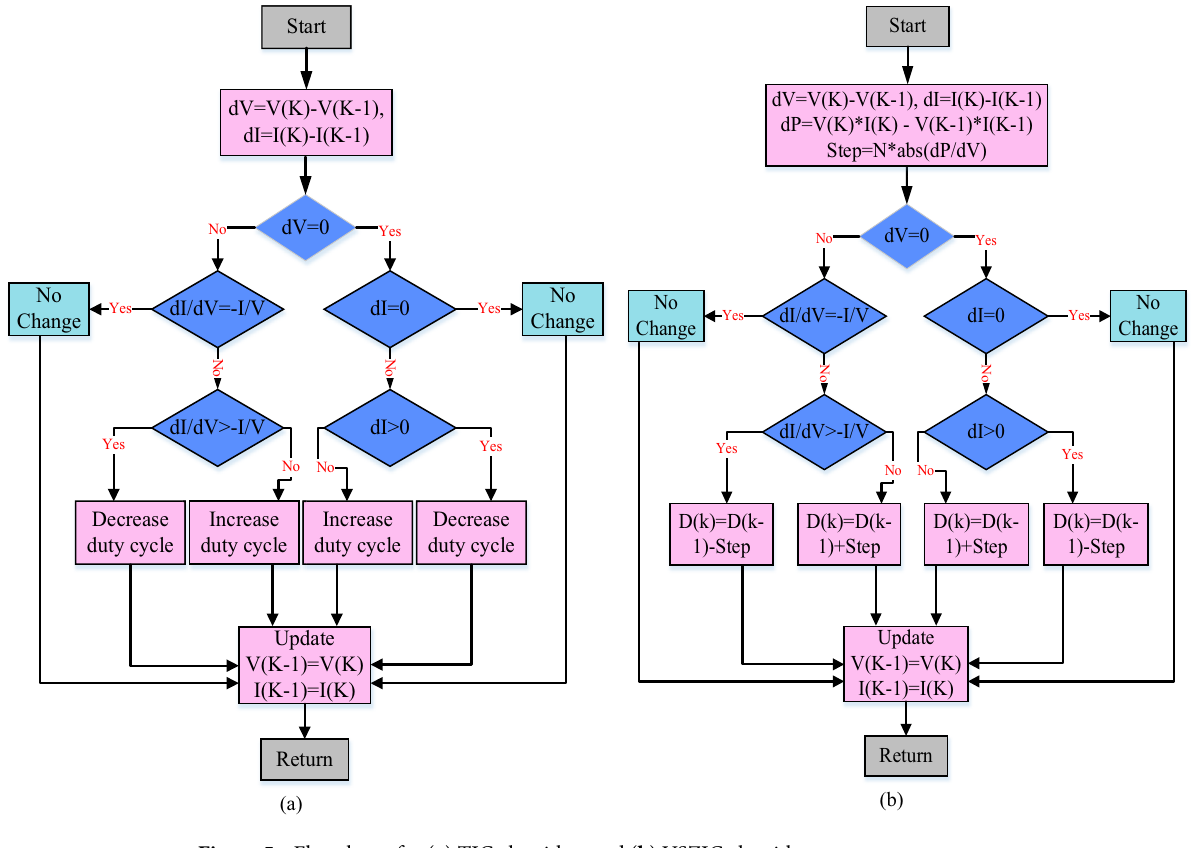
Figure 5. Flowcharts for ( a ) TIC algorithm and ( b ) VSZIC